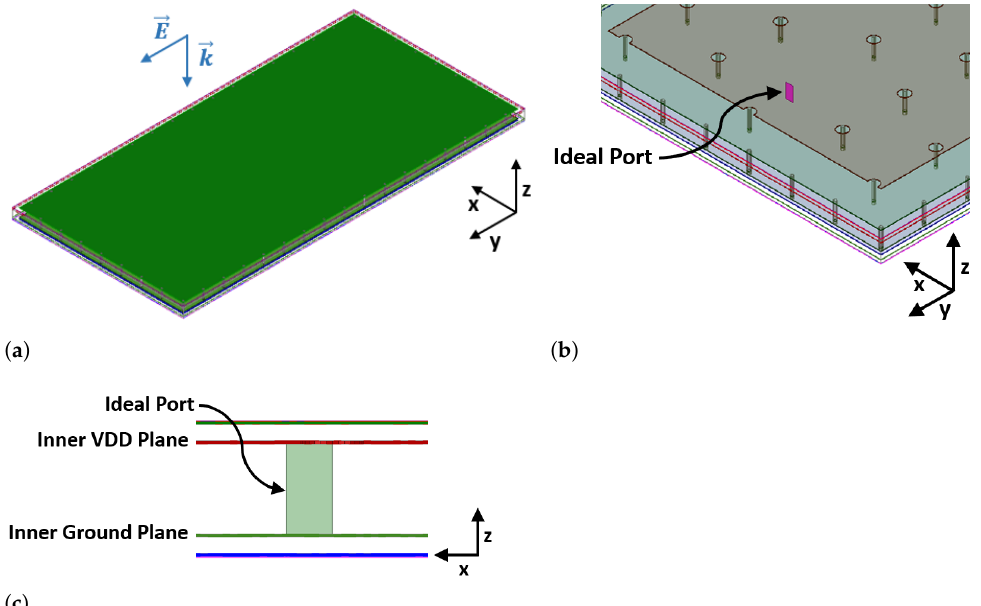
Figure 3. Four-layer ideal PCB: ( a ) 3D model with incident wave normal to the top of the board ( − z direction) and (cid:126) E -field polarized in the y direction, ( b ) 3D model port location, and ( c ) 2D model port location between inner planes.